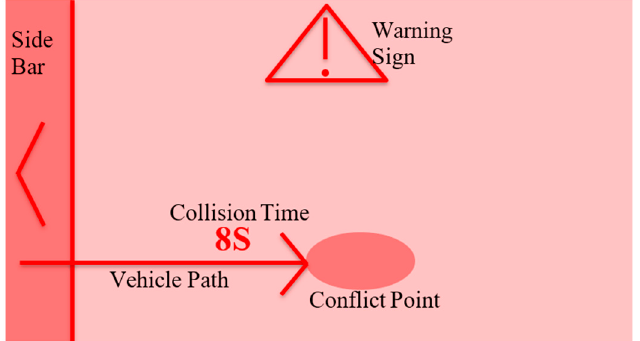
Figure 2. Components in the warning window.